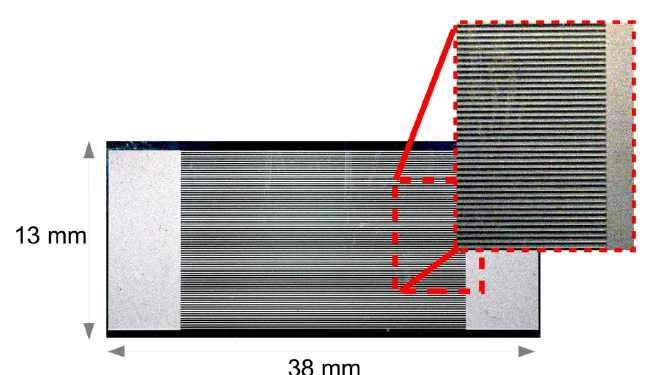
Figure 4. Completed